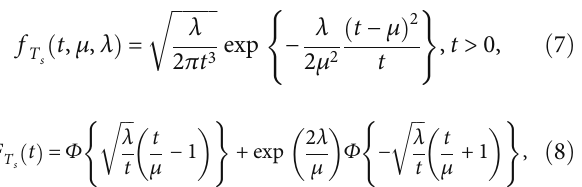
Figure 2: Inverse Gaussian distribution as a function of shape